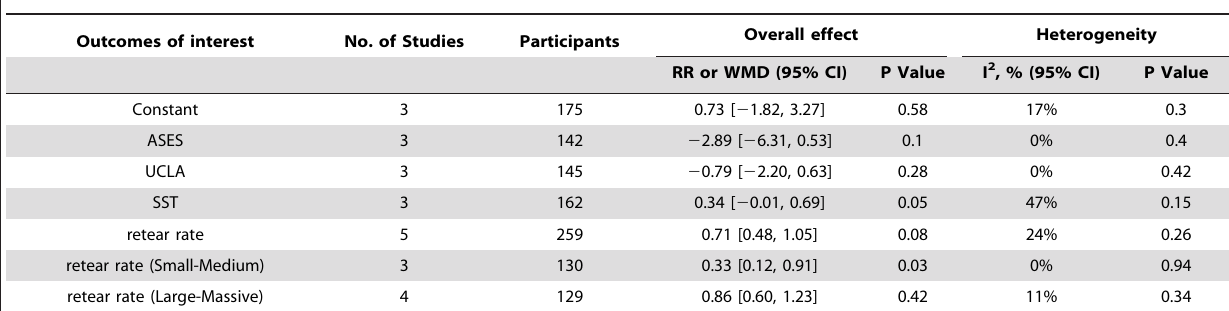
Table 2. Meta-analysis of the outcomes of